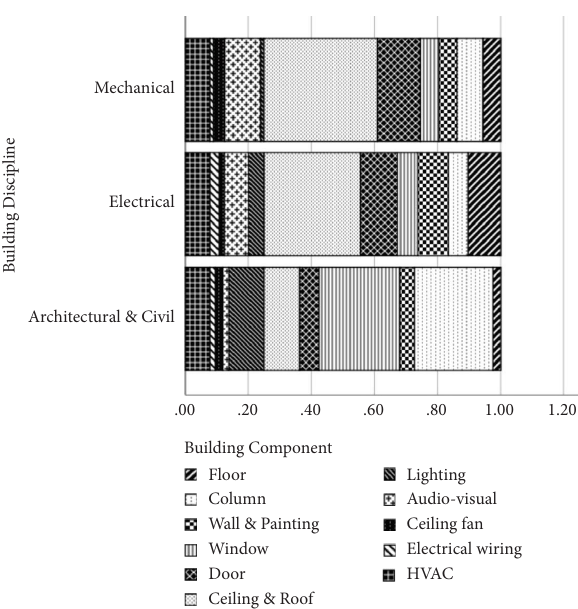
Figure 6: Comparison of building disciplines with respect to each building